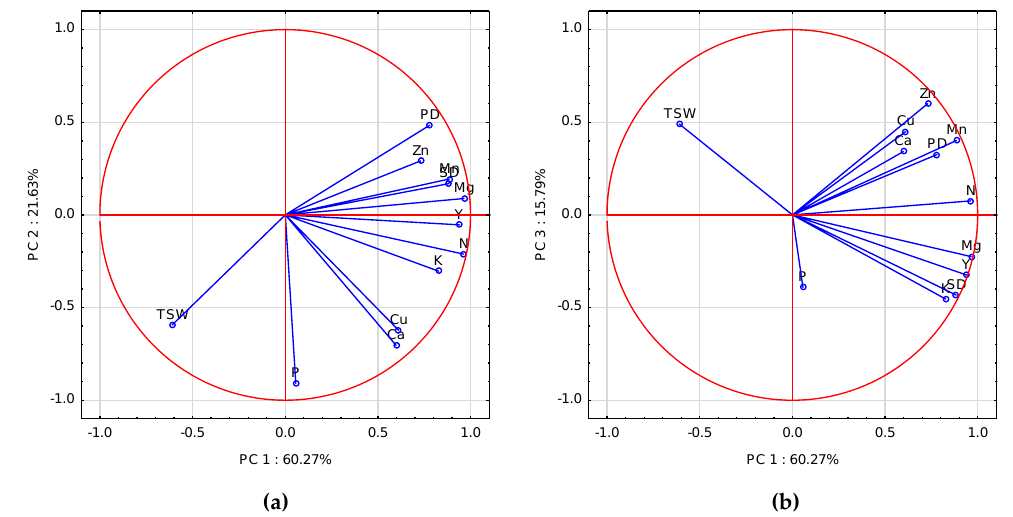
Figure 2. ( a ) Score plot of WOSR components and nutrient accumulated in WOSR seeds in PC1 and PC2 axes. ( b ) Score plot of WOSR components and nutrient accumulated in WOSR seeds in PC1 and PC3 axes. Y—Yield, SD—Seed Density, PD—Pod Density, TSW—Thousand Seed Weight, N, P, K, Mg, Ca, Mn, Zn,